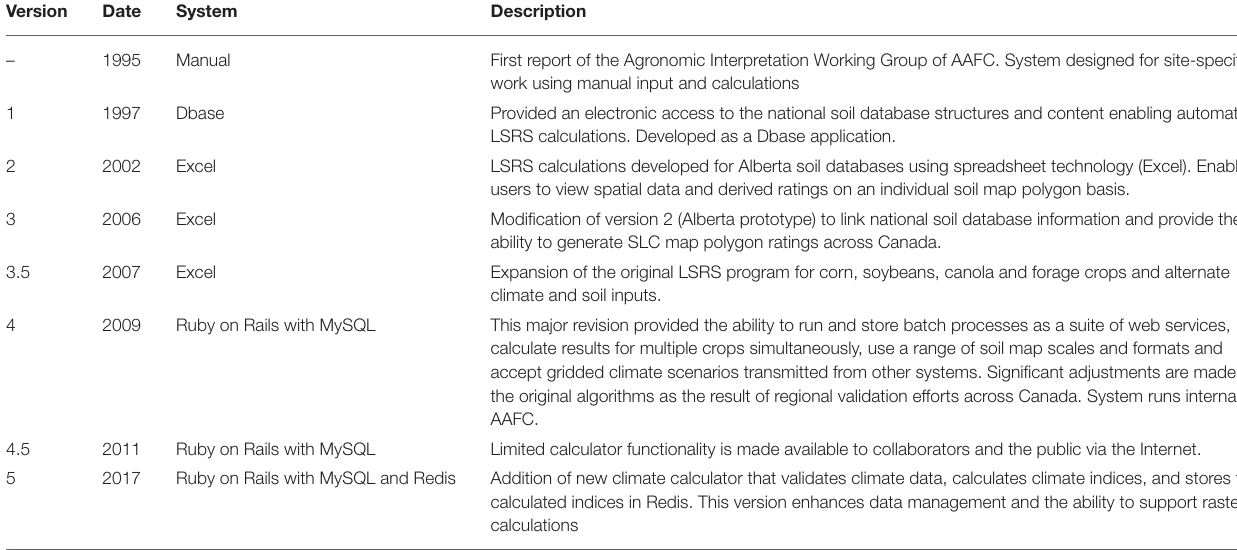
TABLE 3 | Outline of the version history of the land suitability rating system.